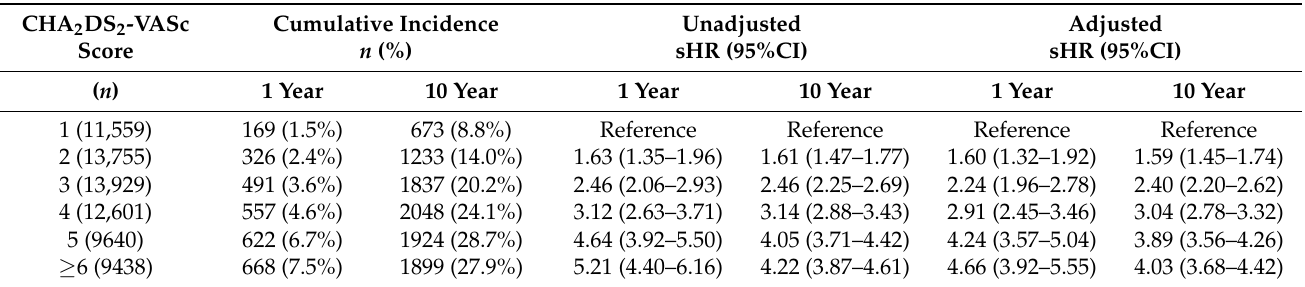
Table 2. Cumulative incidence of new-onset atrial fibrillation after myocardial infarction at one- and ten-year follow-ups by baseline CHA 2 DS 2 -VASc score.